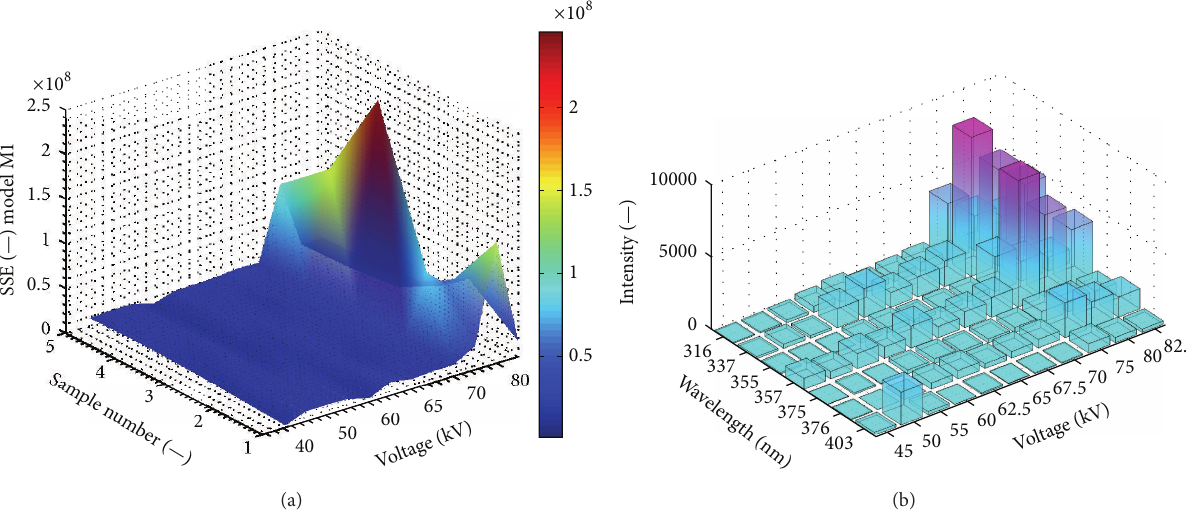
Figure 16: (a) Comparison of SSE coefficient obtained by regression of model M1 for all recorded signals. (b) Voltage dependence of intensity of individual wavelengths obtained by model